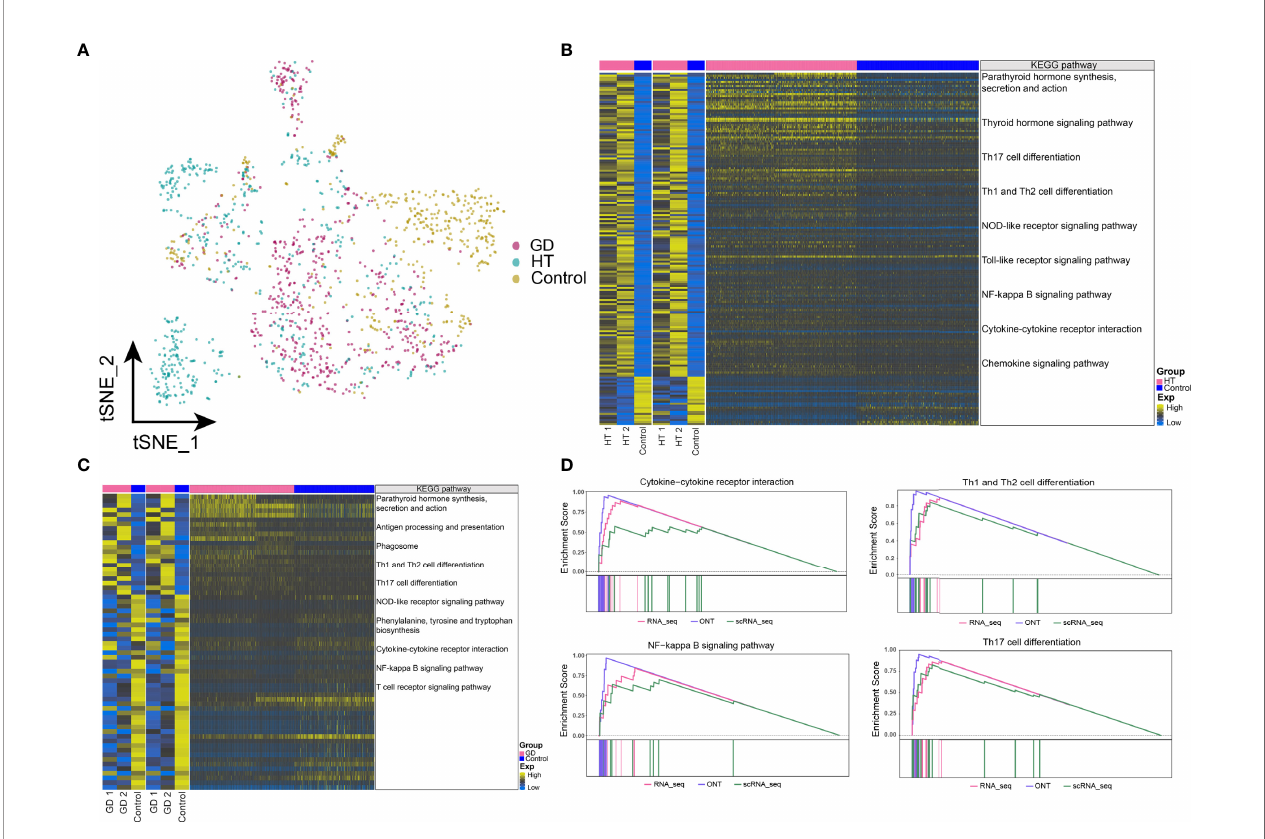
FIGURE 6 | Dysregulated gene expression and abnormal metabolic signaling in microenvironmental macrophages in HT and GD. (A) Single-cell tSNE plots demonstrating HT, GD, and control microenvironmental Mac cell pro fi les. (B, C) KEGG pathway involved in genes with high con fi dence of dysregulated expression at the bulk level and in Mac cells in HT (B) and GD (C) patient. Heatmap of DEGs from ONT sequencing on the left, heatmap of DEGs from RNA sequencing in the middle, and heatmap of DEGs from Mac cells on the right. (D) Composite GSEA plot demonstrating the biological signal of signi fi cant dysregulation of microenvironmental Mac cells in HT. EXP, expression; GD, Graves ’ disease; HT, Hashimoto ’ s thyroiditis; KEGG, Kyoto Encyclopedia of Genes and Genomes; ONT, Oxford Nanopore